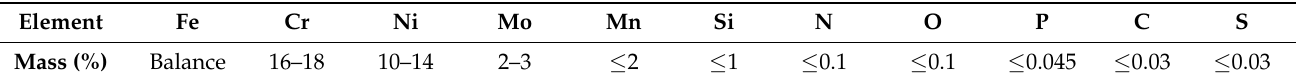
Table 1. SS 316L material composition [46].